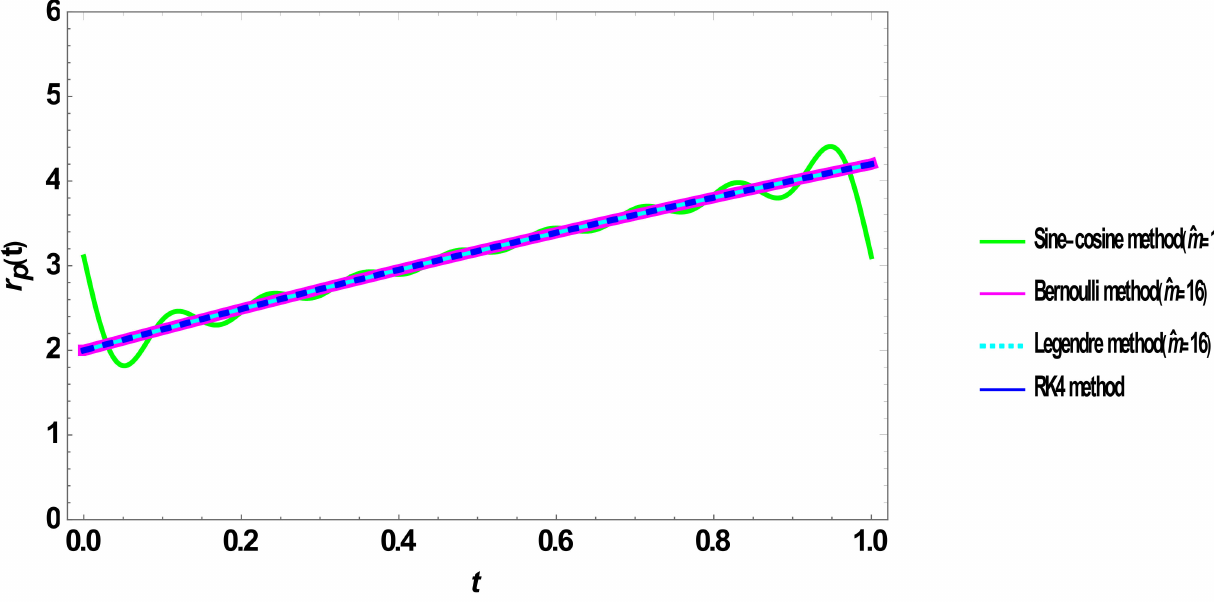
Figure 5. Comparison of the numerical solutions of r p ( t ) by using the sine–cosine wavelets method, Bernoulli wavelets method, ALPs and RK4 methods for υ =